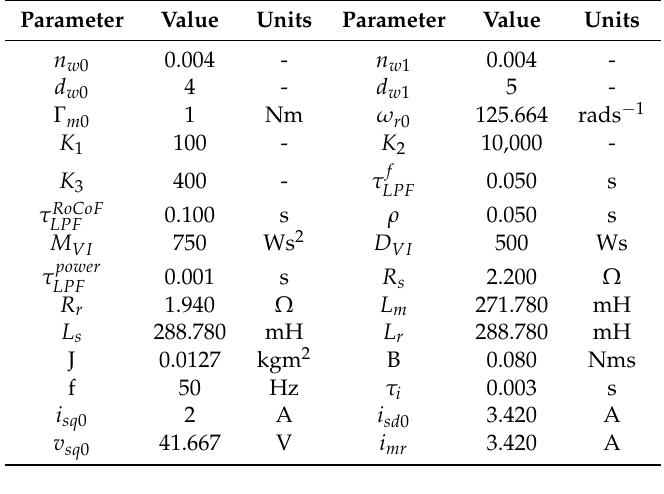
Table 3. Initial operating point and parameter values used for controller design studies.